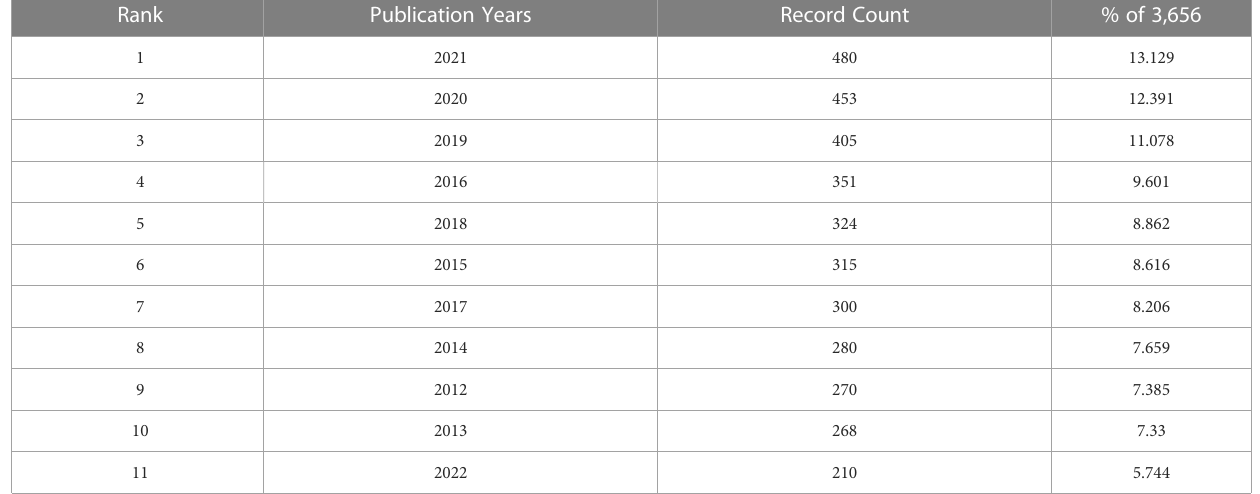
TABLE 1 Annual publication volume and